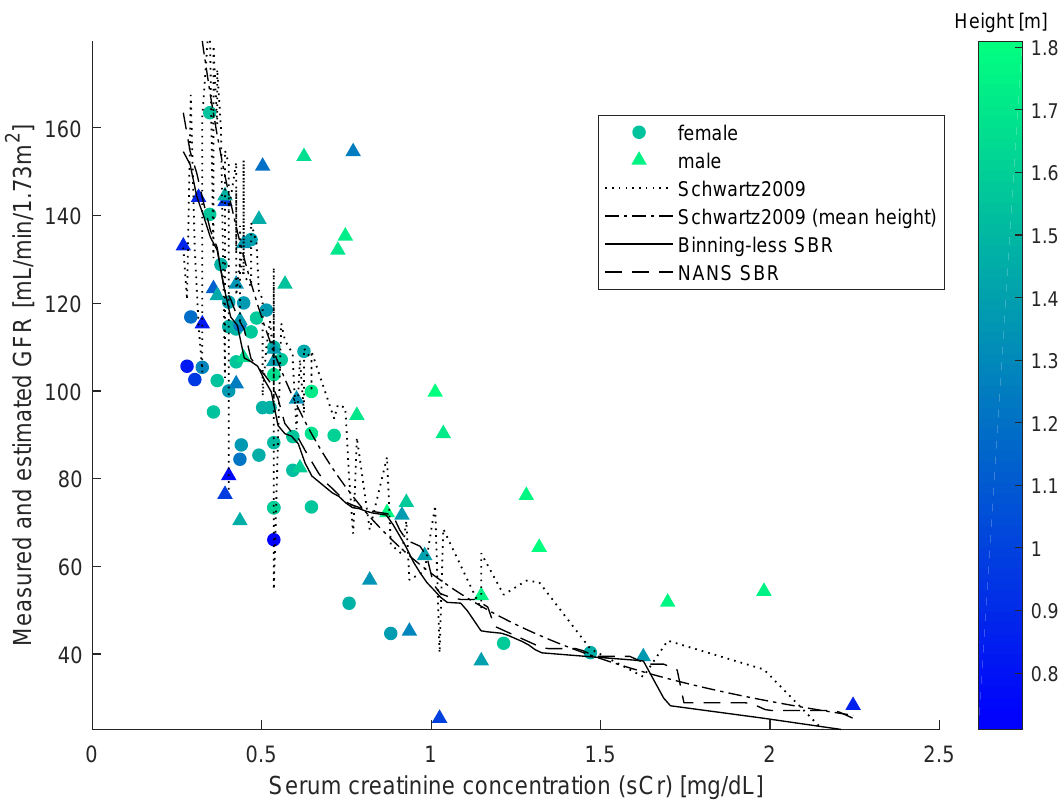
Figure 4. Pedriatic patients’ GFR data set with overlaid numerical model and estimation curves. Comparison of the updated Schwartz equation, the simplified Schwartz equation, the Numerical-Algebraic Neural System (NANS) method introduced in [21] and the proposed method. Serum creatinine concentration refers to the IDMS-traceable